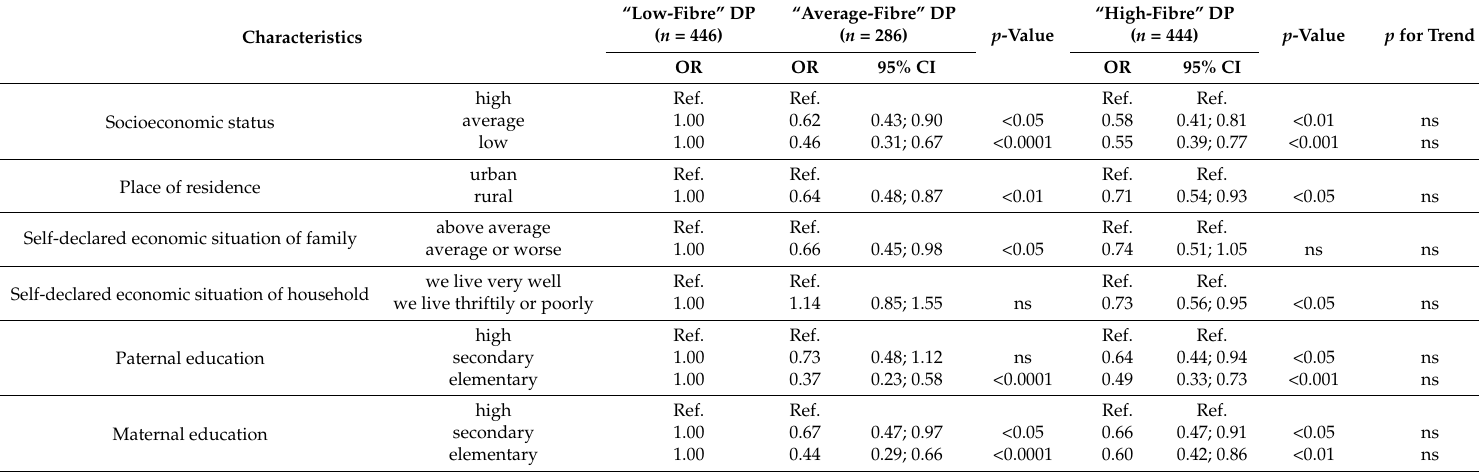
Table 2. Odds ratios (ORs with 95% confidence interval (95% CI)) of fibre dietary patterns (DPs) by socioeconomic status and its single factors in Polish adolescents.